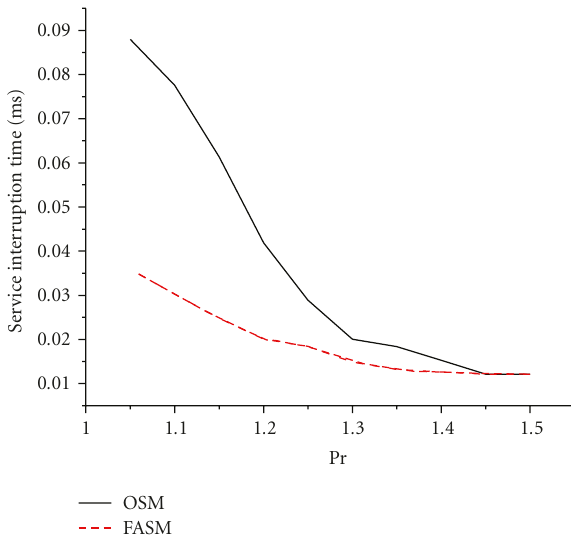
Figure 14: Service interruption time versus